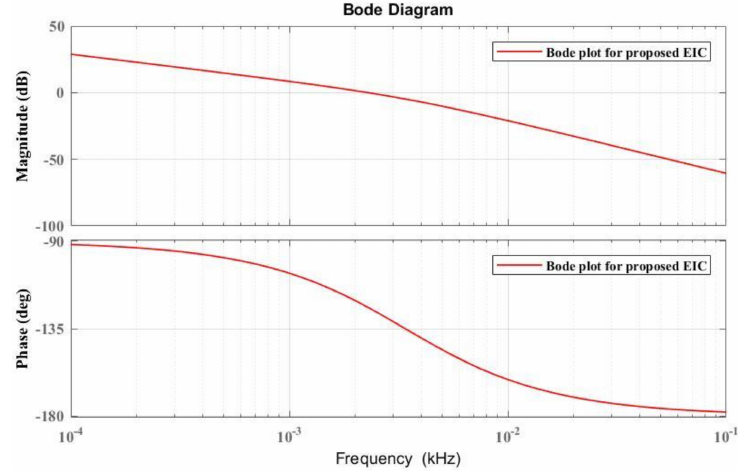
Figure 9. Bode plot for proposed EIC.